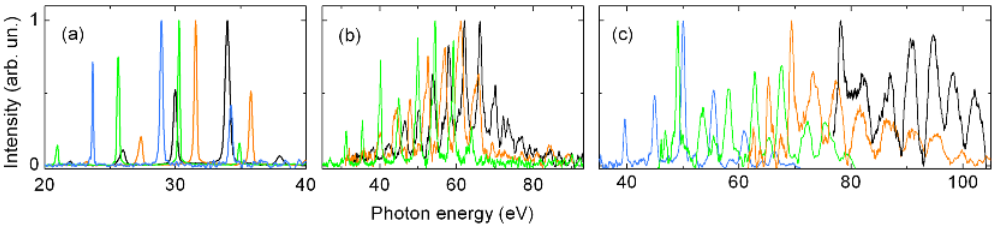
Fig. 1. Linear scale HHG spectra for Ar (a), Ne (b), He